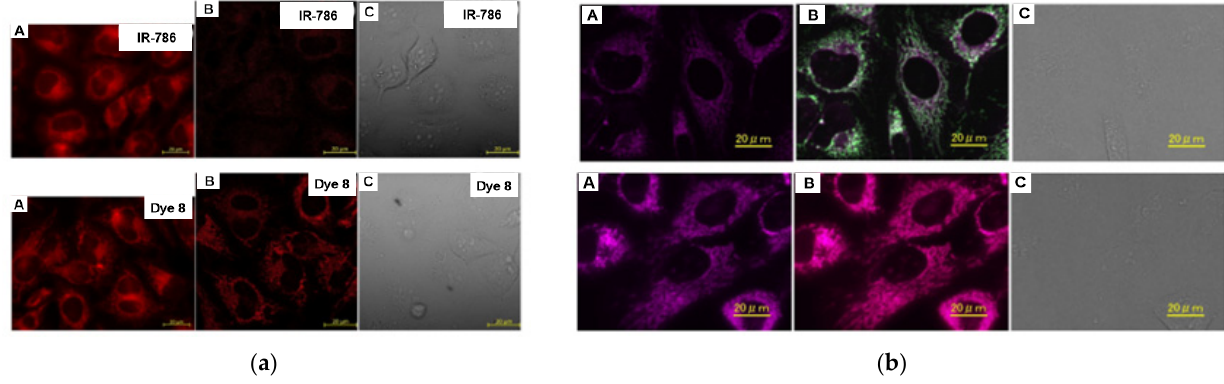
Figure 8. ( a ) ( A ) Epifluorescence, ( B ) confocal, and ( C ) differential interference contrast images of HeLa cells stained with (row 1) IR-786 iodide and (row 2) Dye 8 . ( b ) ( A ) Colocalization images of ( A ) Dye 8 and ( B ) MitoTracker Green (top)/MitoTracker Red (bottom) in mitochondria, and ( C ) differential interference contrast images. Adapted from [27].